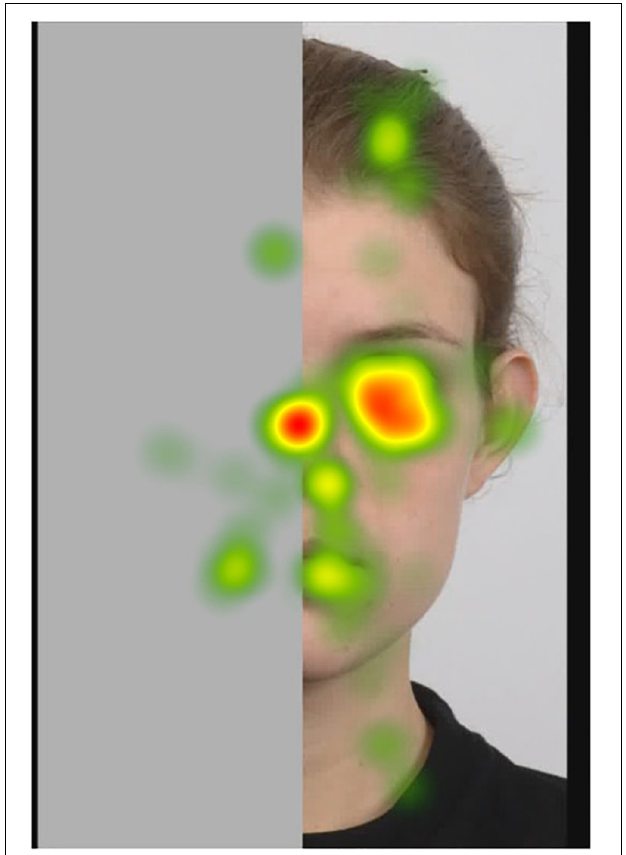
FIGURE 5 | Fixation heatmap of a right upright